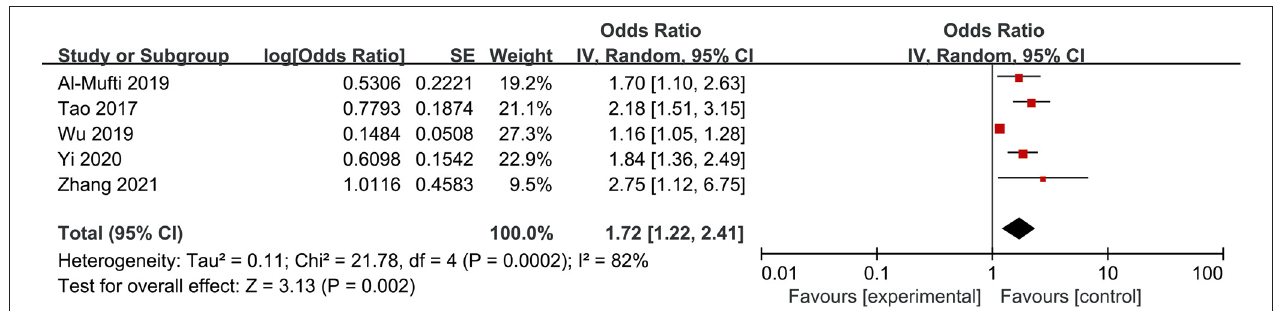
FIGURE 3 | Meta-analysis of the association between NLR and the occurrence of